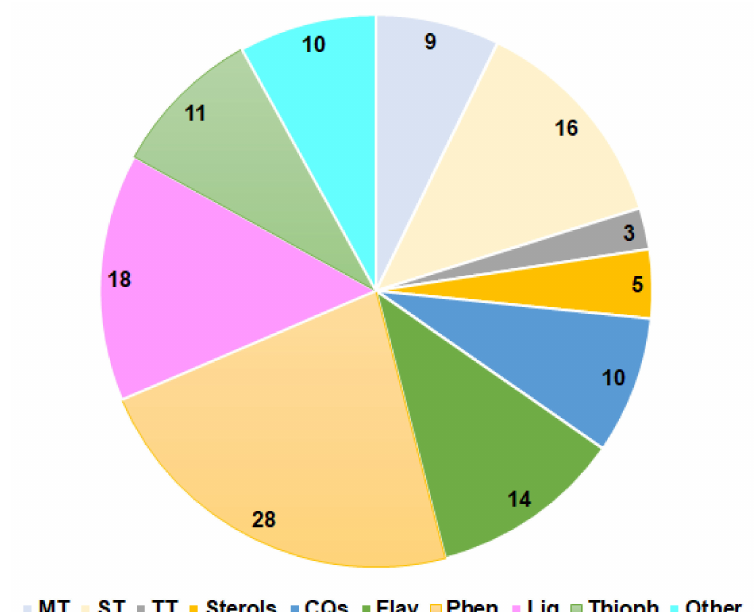
Figure 14. Number of metabolites from various classes reported from P . indica . MT: Monoterpenes; ST: Sesquiterpenes; TT: Triterpenes; CQs: Caffeoylquinic acid derivatives; Flav: Flavonoids; Phen: Phenolics; Lig: Lignans; Thioph: Thiophenes.